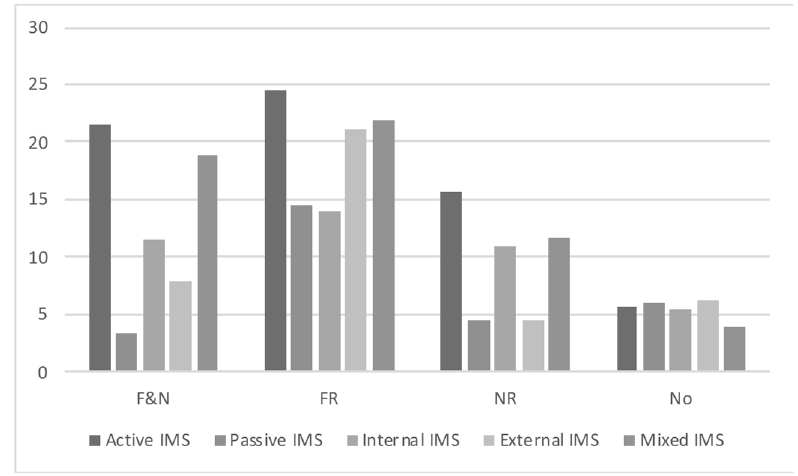
Figure 16. The average number of ideas selected per task, depending on the reward and IMS types. Source: created by the authors.